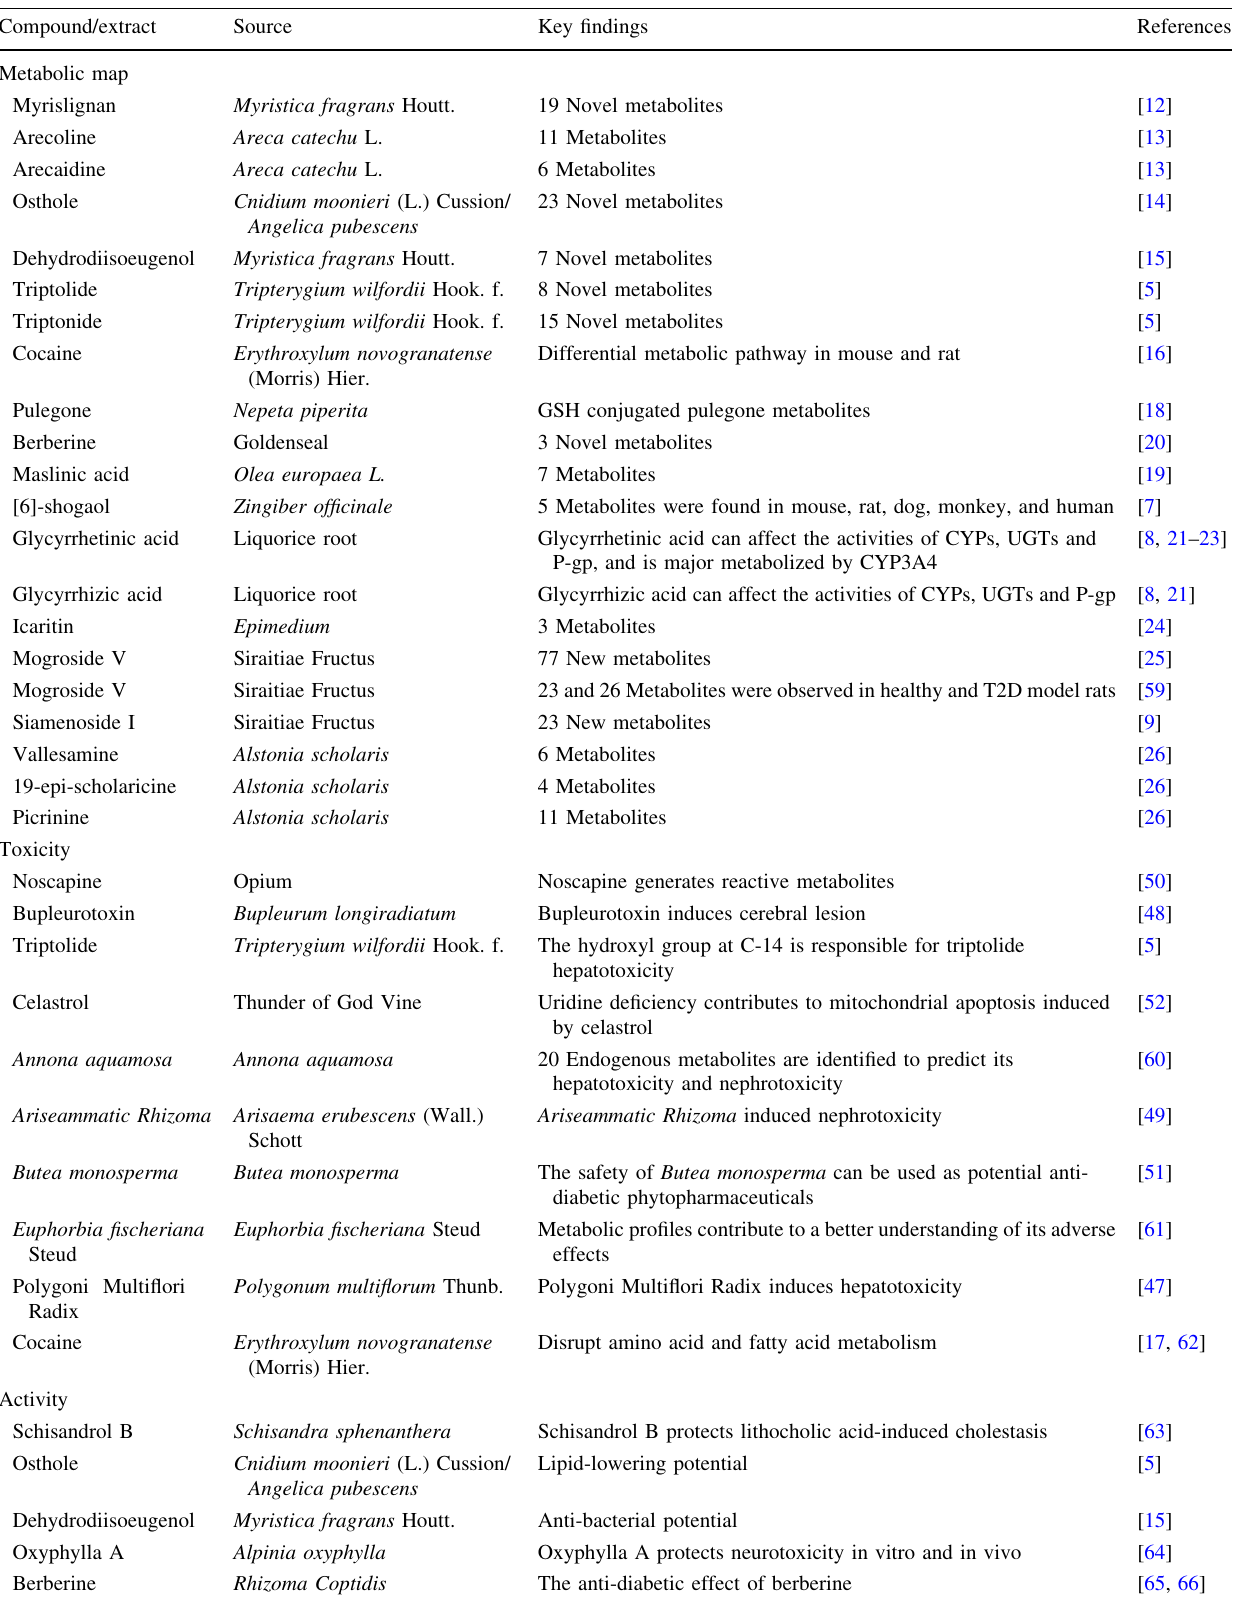
Table 1 List of metabolomics application in the study of natural products Compound/extract Source Key